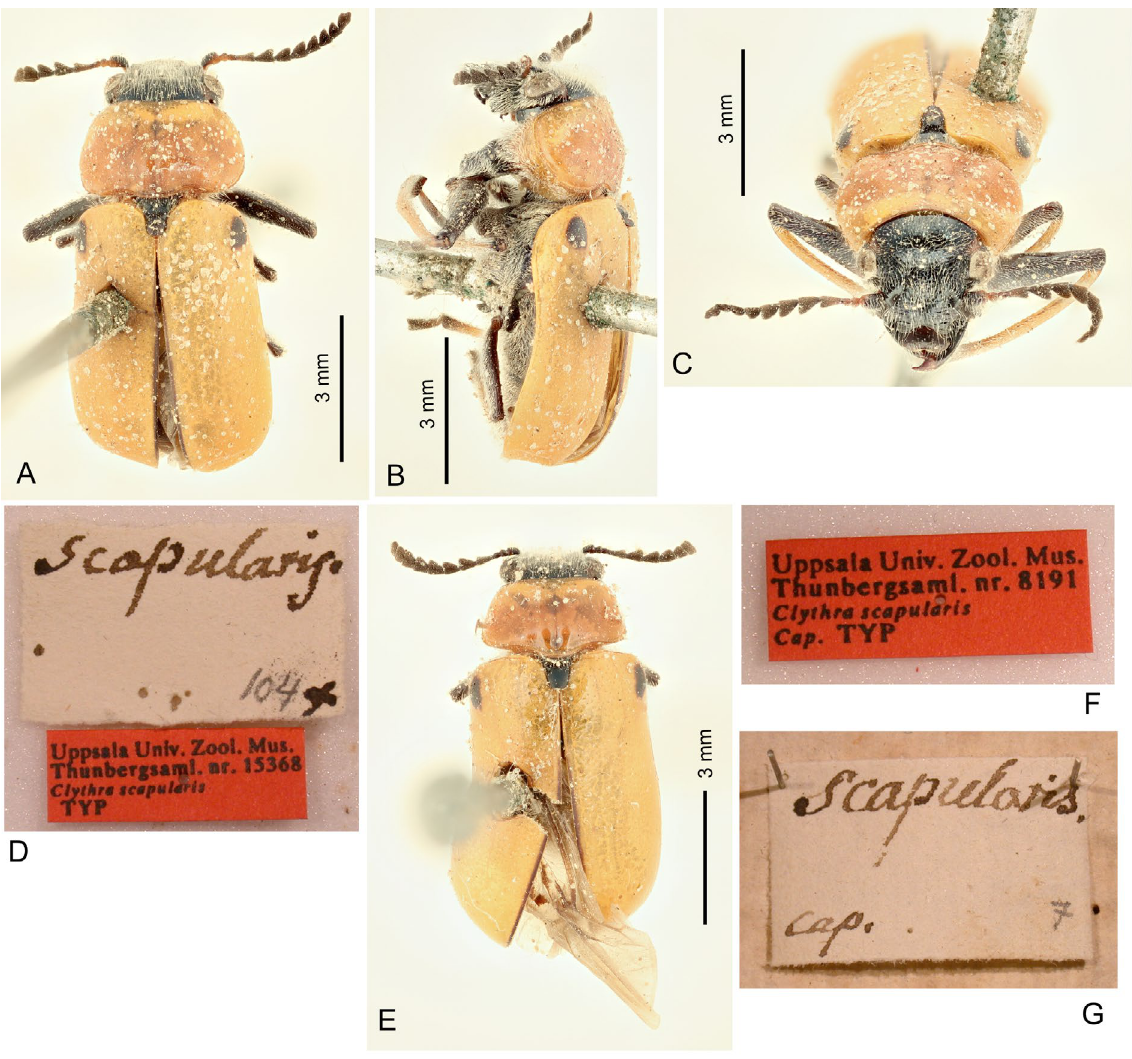
Fig. 10. Phoenicodera scapularis (Thunberg, 1821). A–D . Syntype, ♂, 9.0 mm, UUZM. A . Dorsal view. B . Lateral view. C . Frontal view. D . Label and box label. E–G . Syntype, ♀, 7.8 mm, UUZM. E . Dorsal view. F . Label. G . Box